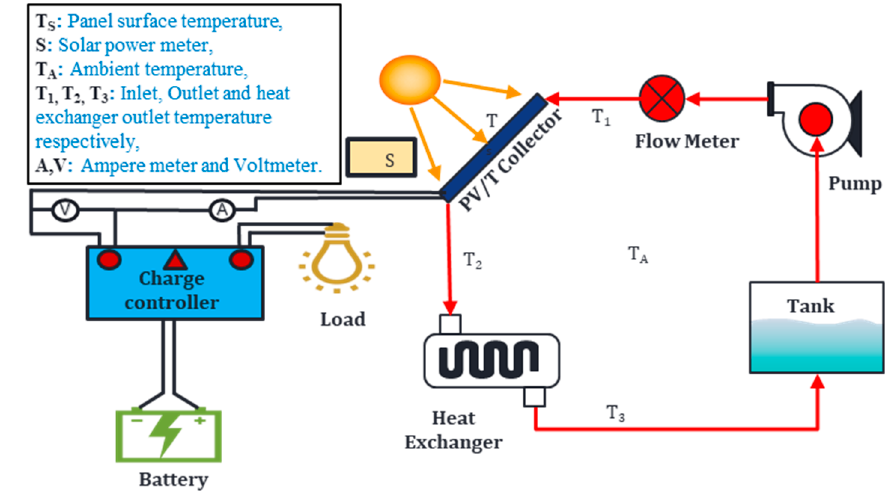
Figure 2. Typical model of a conventional PV/T system.